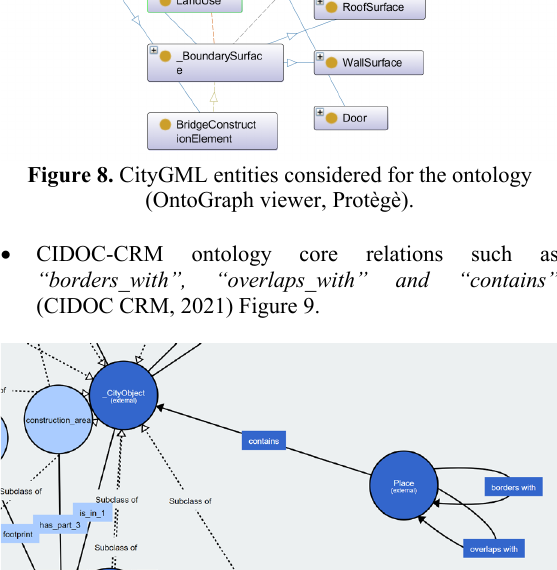
Figure 9. CIDOC -CRM ontologies relations selected for the present study.